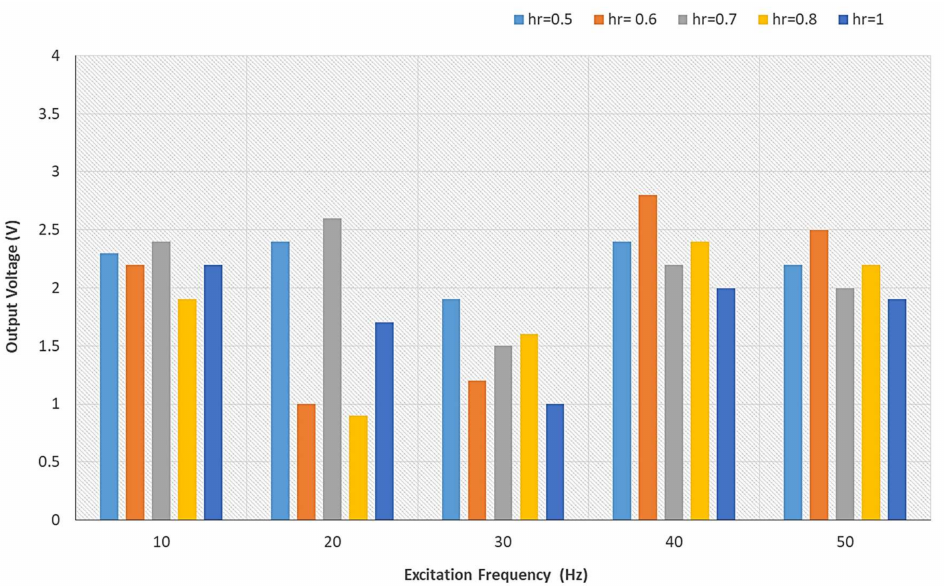
Figure 8. Output voltage for PZT patches embedded at varying depths in the transverse